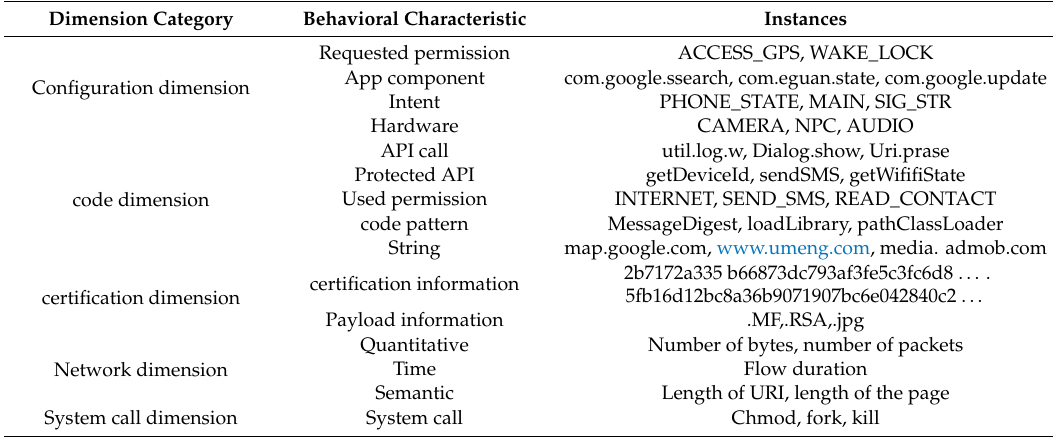
Table 1. Detail information of the extracted behavioral characteristic.